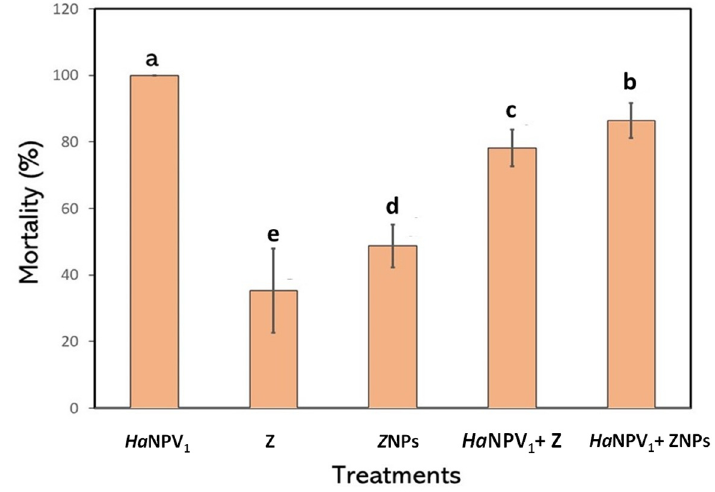
Figure 4. Mortality of larvae treated with di ff erent virus formulations and only the virus Ha NPV 1 as a control. The le tt er a–e indicate signi fi cant di ff erence within treatments (Duncan’s Multiple Range Test, p < 0.05).